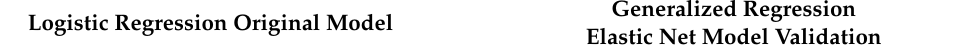
Table 3. Significant factors contributing to the differences between the internet-based application against Nutrition Data System for Research on total calories.